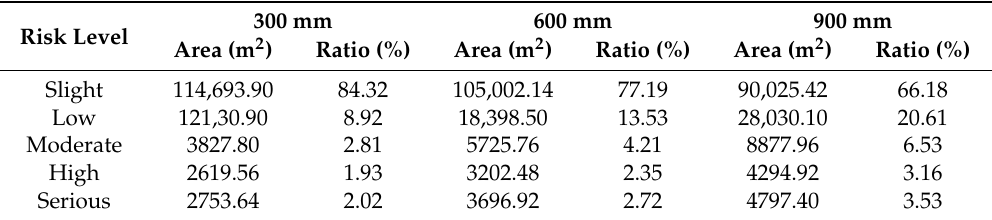
Table 5. Results of landslide risk obtained by the 2005 tested